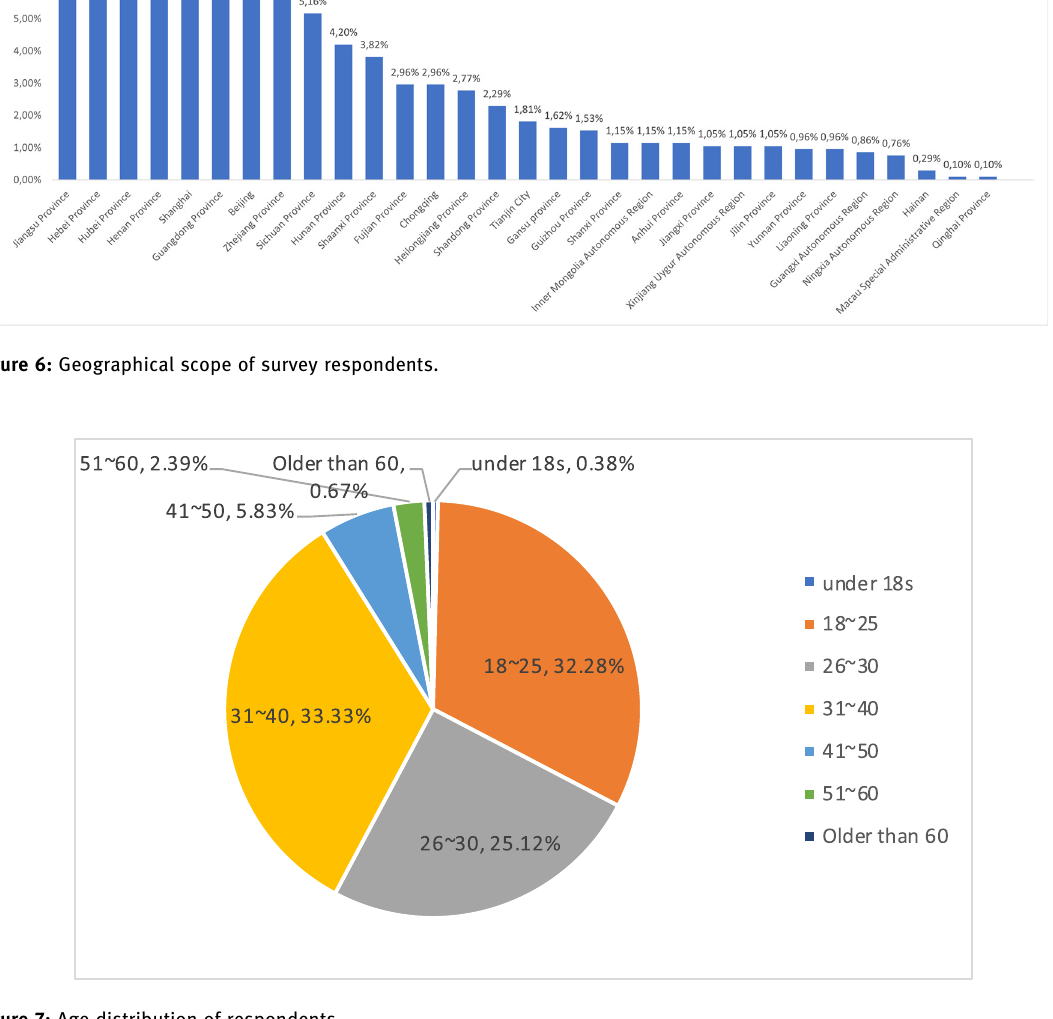
Figure 7: Age distribution of